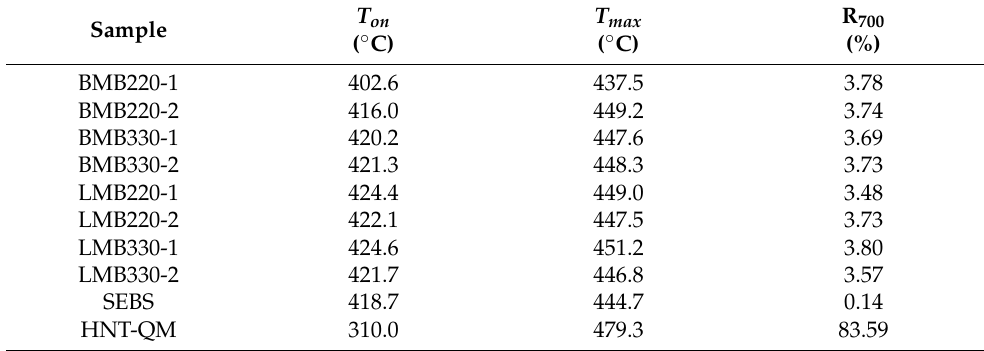
Table 2. Characteristic temperatures and residue at 700 °C for SEBS, HNT-QM and masterbatches. Sample